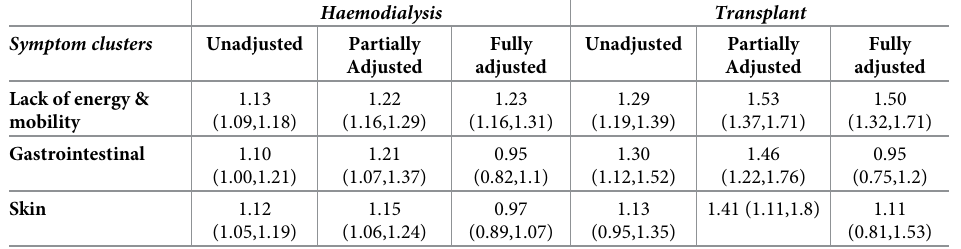
Table 4. Association between within-person change in total symptom cluster scores and within-person change in ability to perform usual activities.